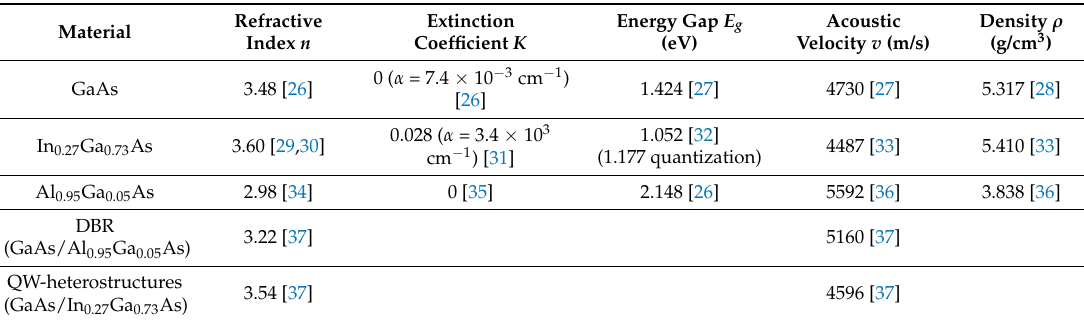
Table 2. Properties of MQW-SESAM sample at a wavelength of λ = 1048.3 nm.